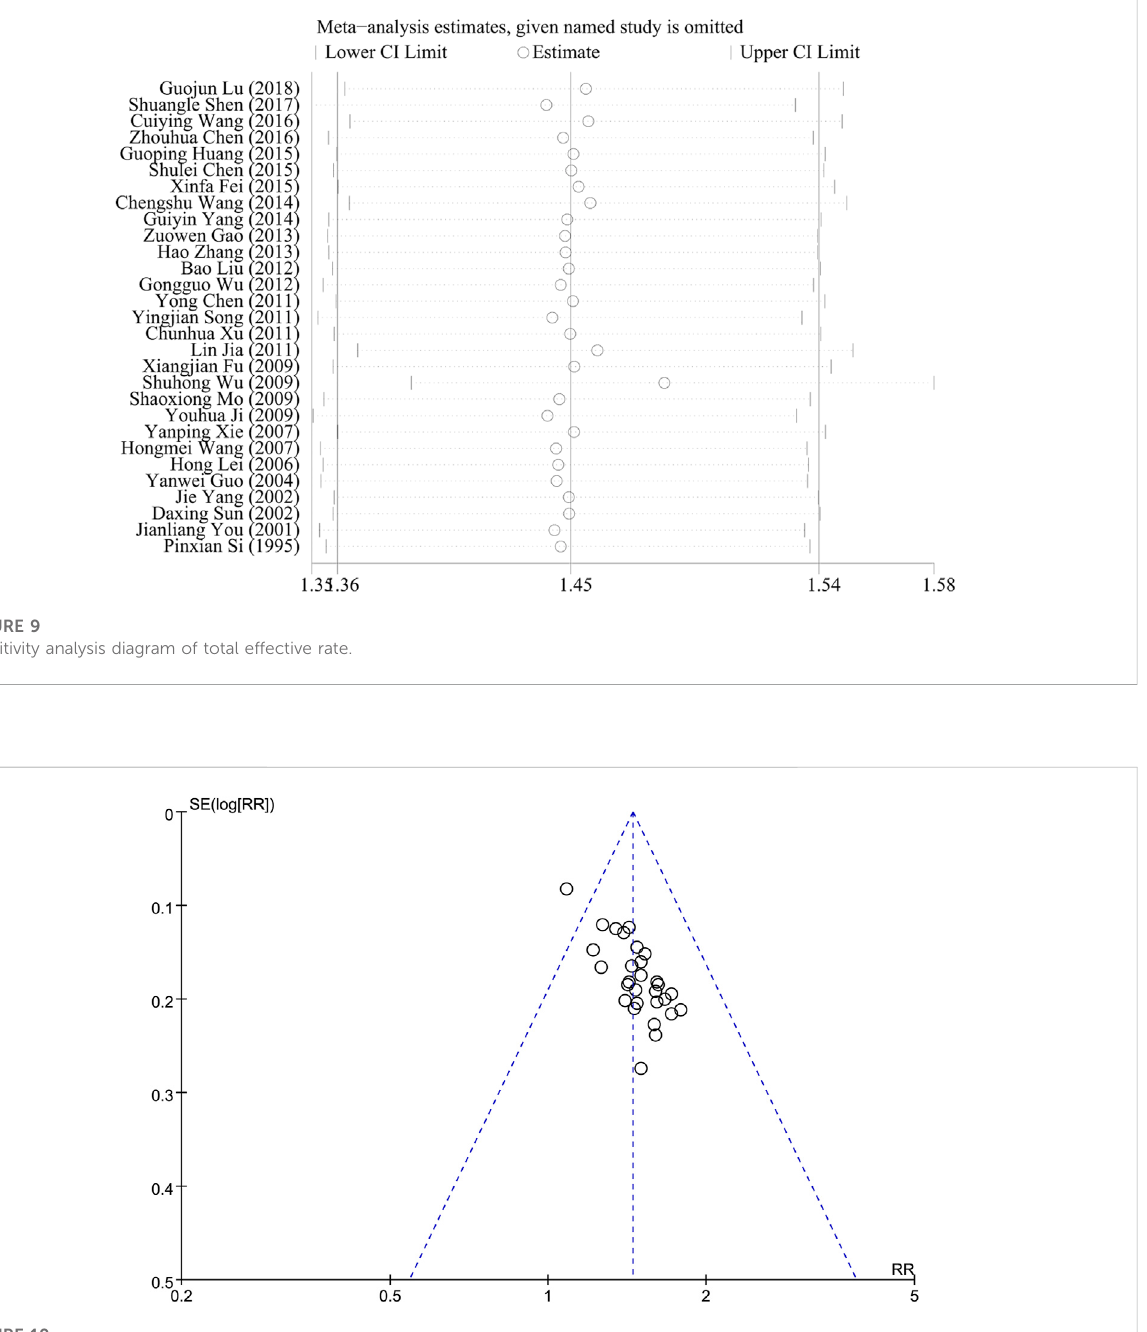
FIGURE 10 Funnel plot of total clinical